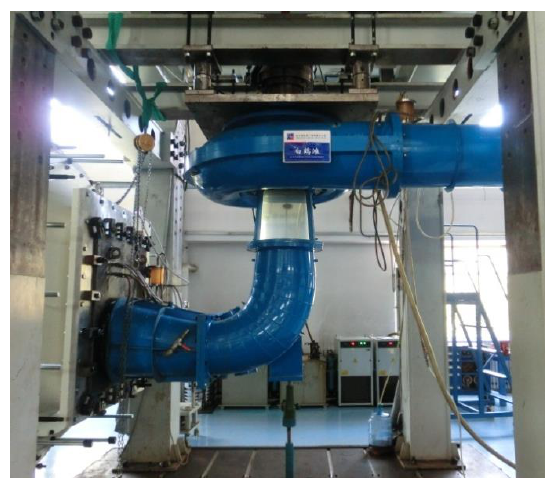
Figure 3. Model Francis turbine of test rig. Table 2. Main parameters of model test rig.